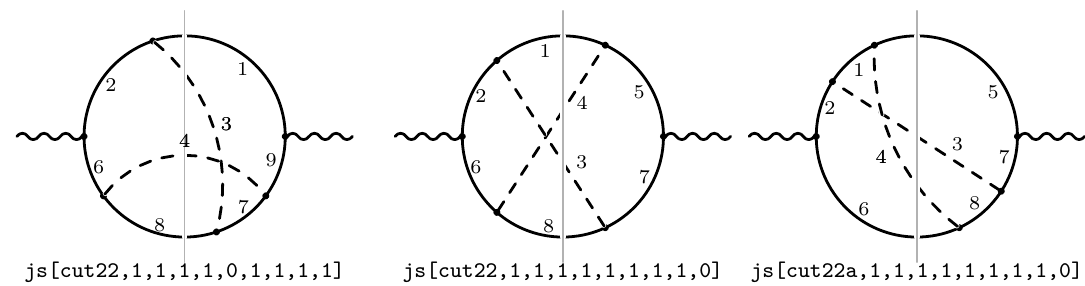
Figure 4 . Prototypes for master integrals of (2 , 2)